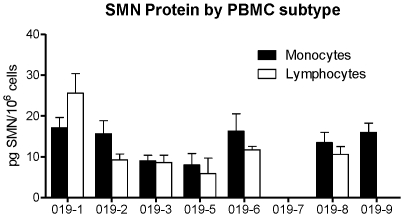
Quantitation of SMN by PBMC subtype.There was no significant difference in SMN protein levels between human lymphocytes and monocytes fractions separated from PBMCs. SMN protein was detectable in the majority of samples for both cell types, ranging from 6.8–25.8 pg/106 cells for lymphocytes and 8–17.5 pg/106 cells for monocytes. Error bars represent standard deviations.